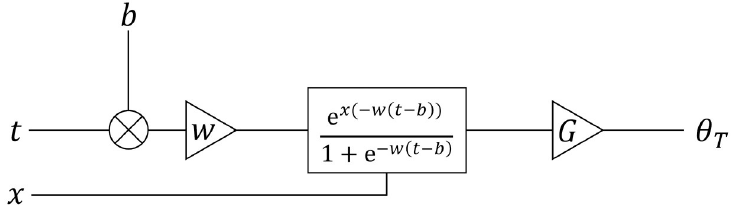
Fig 4. Model to estimate thigh angle. A model based on an artificial neuron with a sigmoid activation function to estimate stand-to-sit thigh angle where, t is the input time segment of stand-to-sit transition, weight w determines the speed of transition, bias b determines the centre of transition, x is classifier 2 output where x = 0 for stand-to-sit and x = 1 for sit-to-stand transition, gain G scales the output of activation function between 0˚ and 90˚ and the thigh angle θ T is the